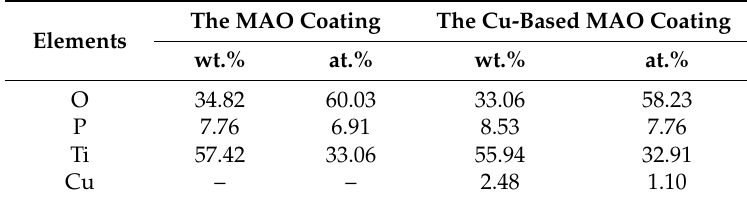
Table 2. EDS area spectra results of the MAO and the Cu-based MAO coatings.